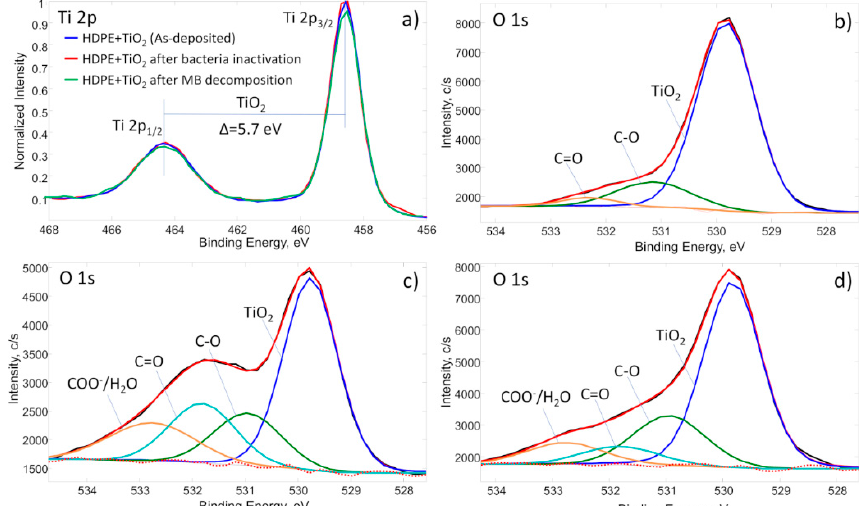
Figure 5. XPS deconvolution spectra: ( a ) Ti 2p spectra at normalized intensity including as-deposited HDPE + TiO 2 (blue line), HDPE + TiO 2 after bacterial inactivation (red line) and HDPE+TiO 2 after MB decomposition (green line); ( b ) O 1s spectra of as-deposited HDPE + TiO 2 ; ( c ) O 1s spectra of HDPE + TiO 2 after MB decomposition; ( d ) O 1s spectra of HDPE + TiO 2 after bacterial inactivation.